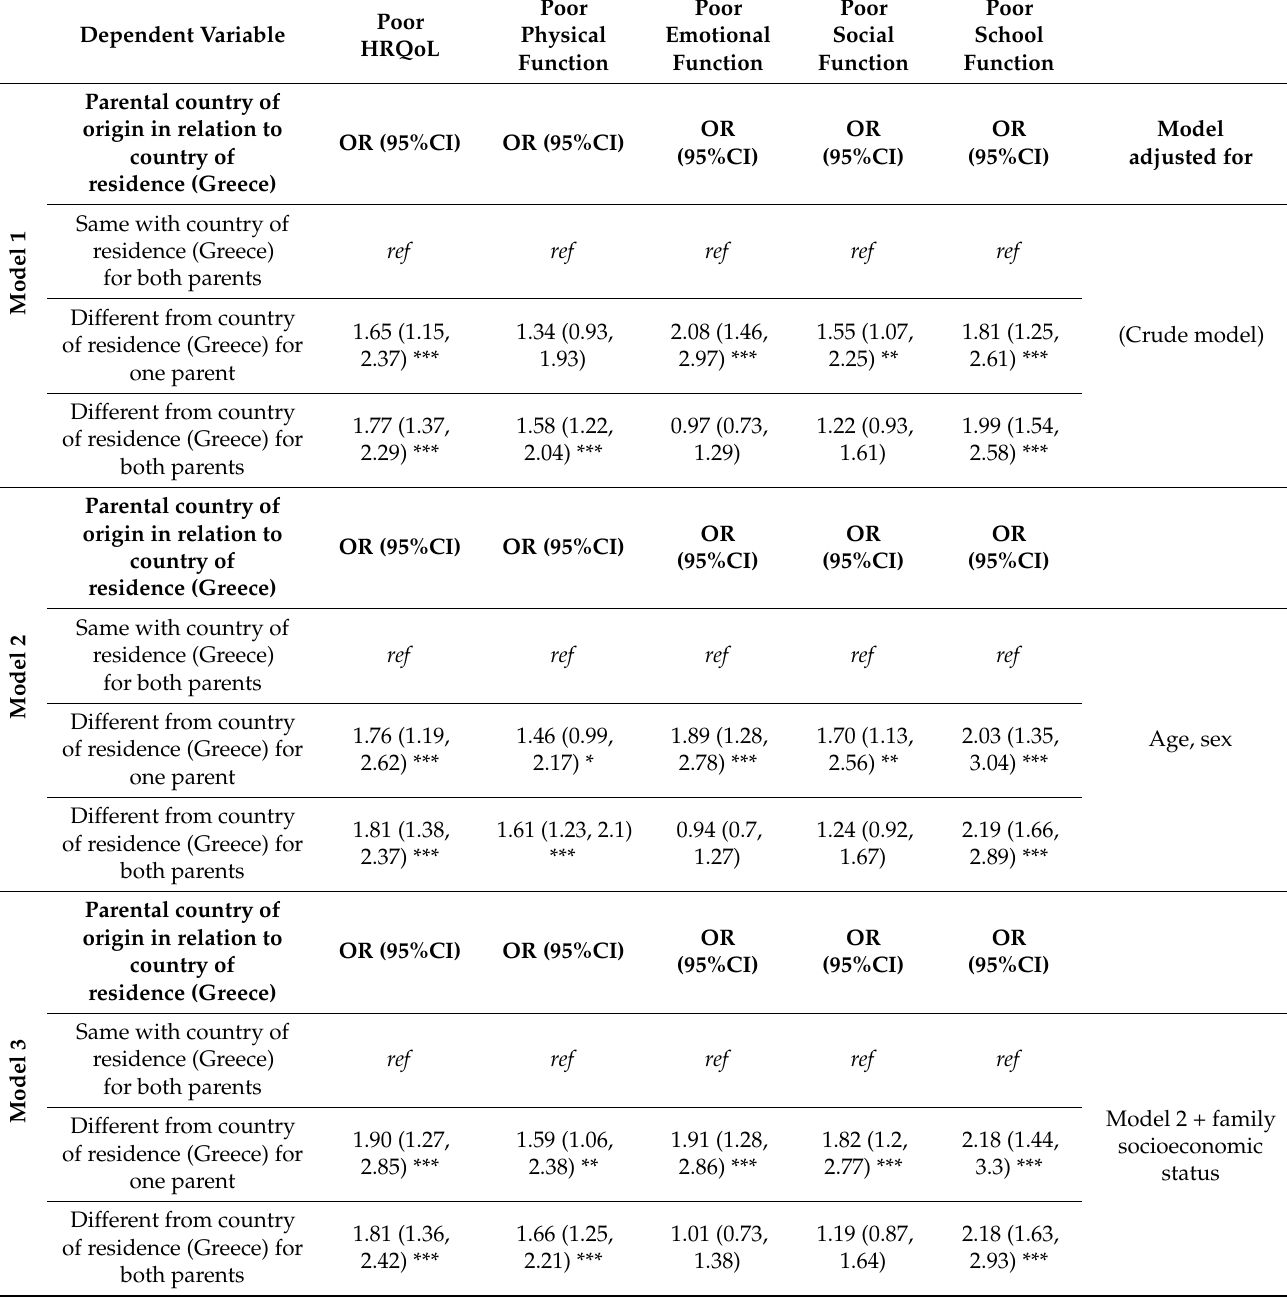
Table 4. Logistic regression models to evaluate the association between parental country of origin and parent-perceived quality of life of students participating in the DIATROFI